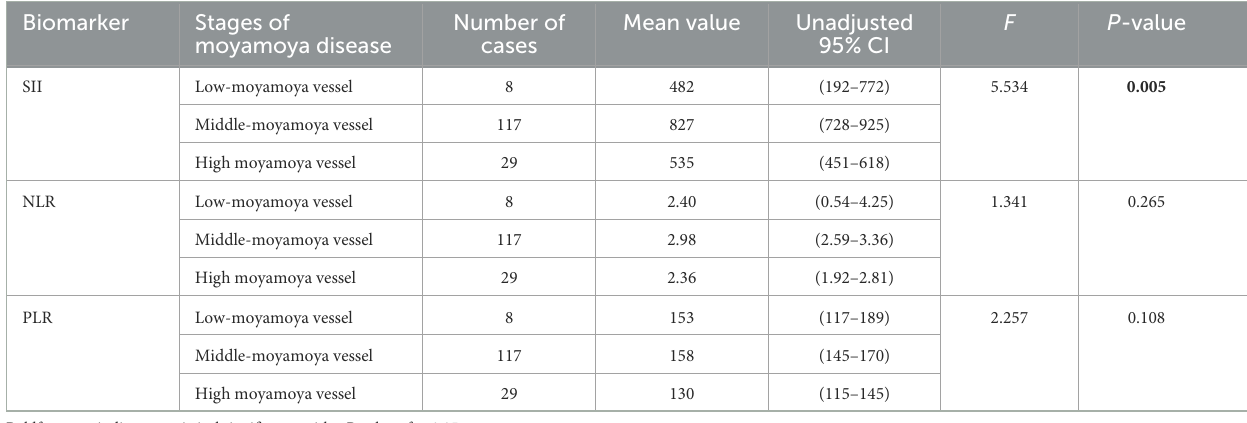
TABLE 4 Comparison of biomarkers in different stages of moyamoya